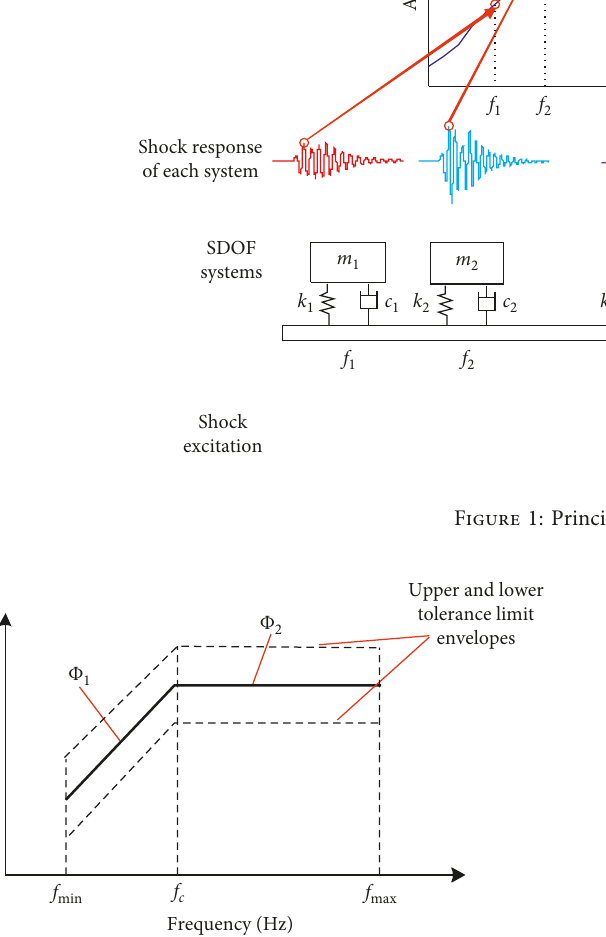
Figure 2: Typical specifications for SRS.